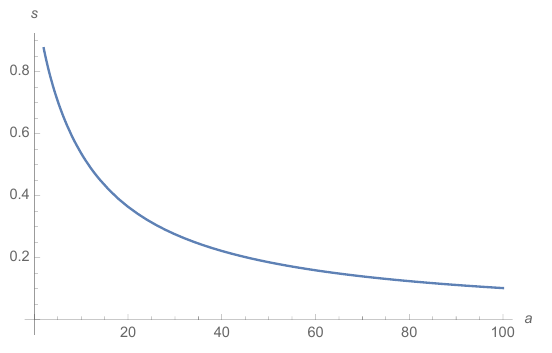
Figure 6 . Plot of s